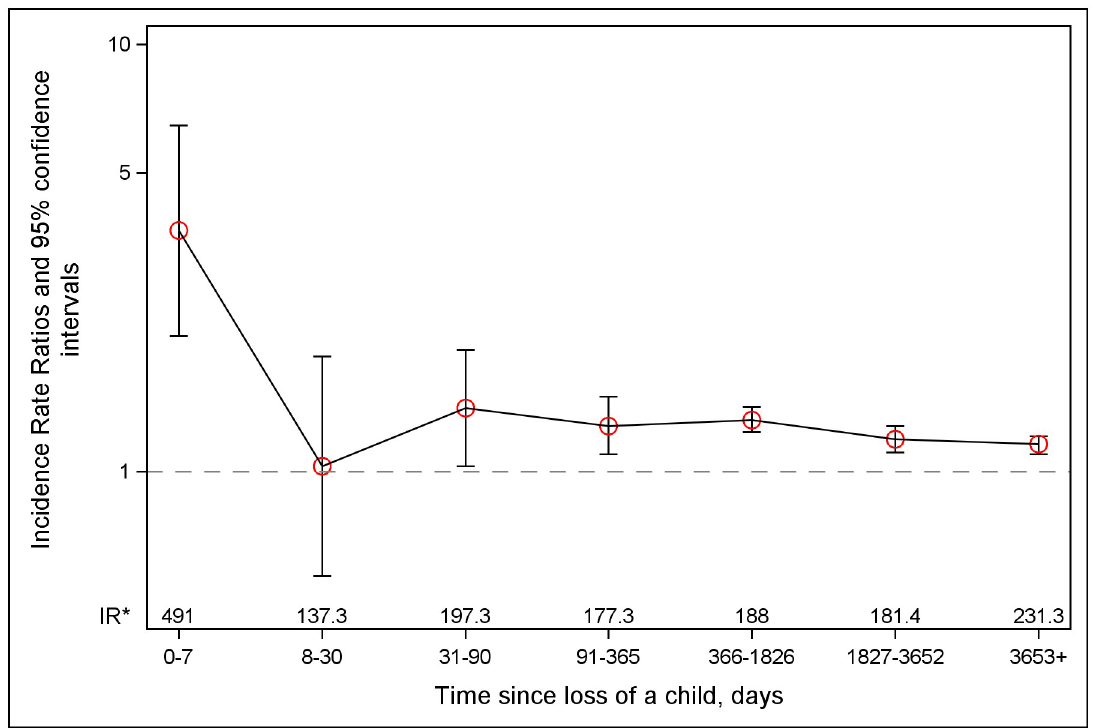
Fig 2. IRRs and 95% CIs for AMI according to time since the death of a child. � IR, incidence rate; the incidence rate (per 100,000 person-years) of AMI in the exposed group. AMI AU : AnabbreviationlisthasbeencompiledforthoseusedinFig 2 : Pleaseverifythatallentriesarecorrect : , acute myocardial infarction; CI, confidence interval; IRR, incidence rate ratio.